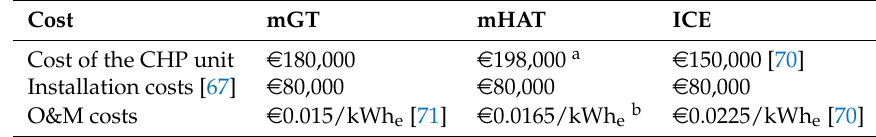
Table 3. Capital and operation and maintenance costs for the mGT, mHAT and